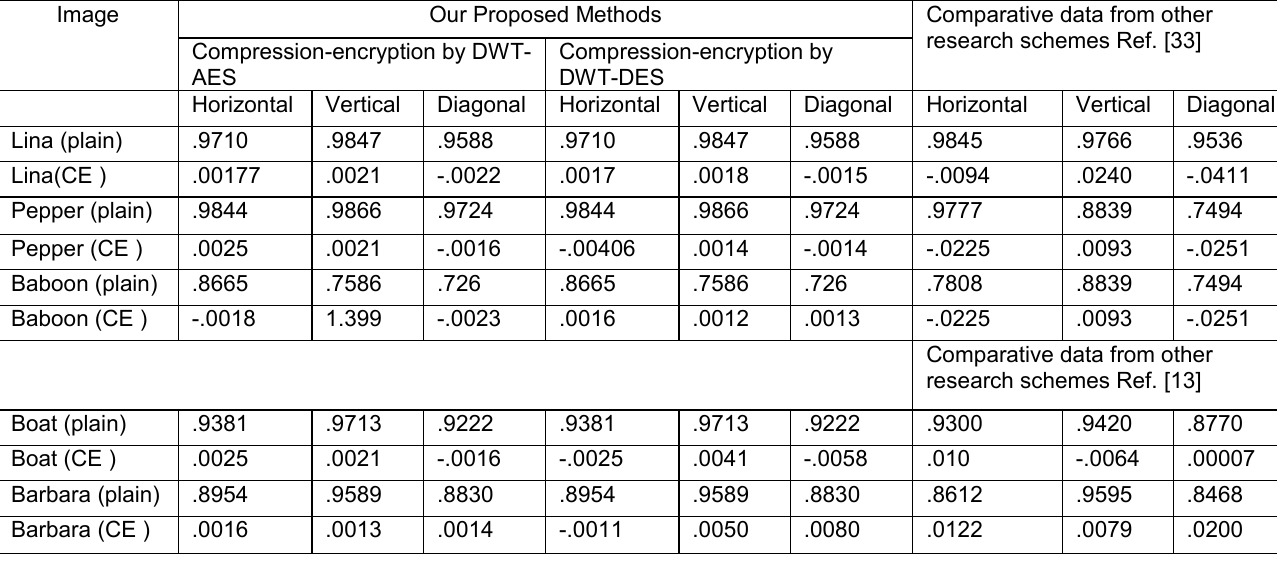
Table 6. Comparison of correlation coefficient for different compression encryption